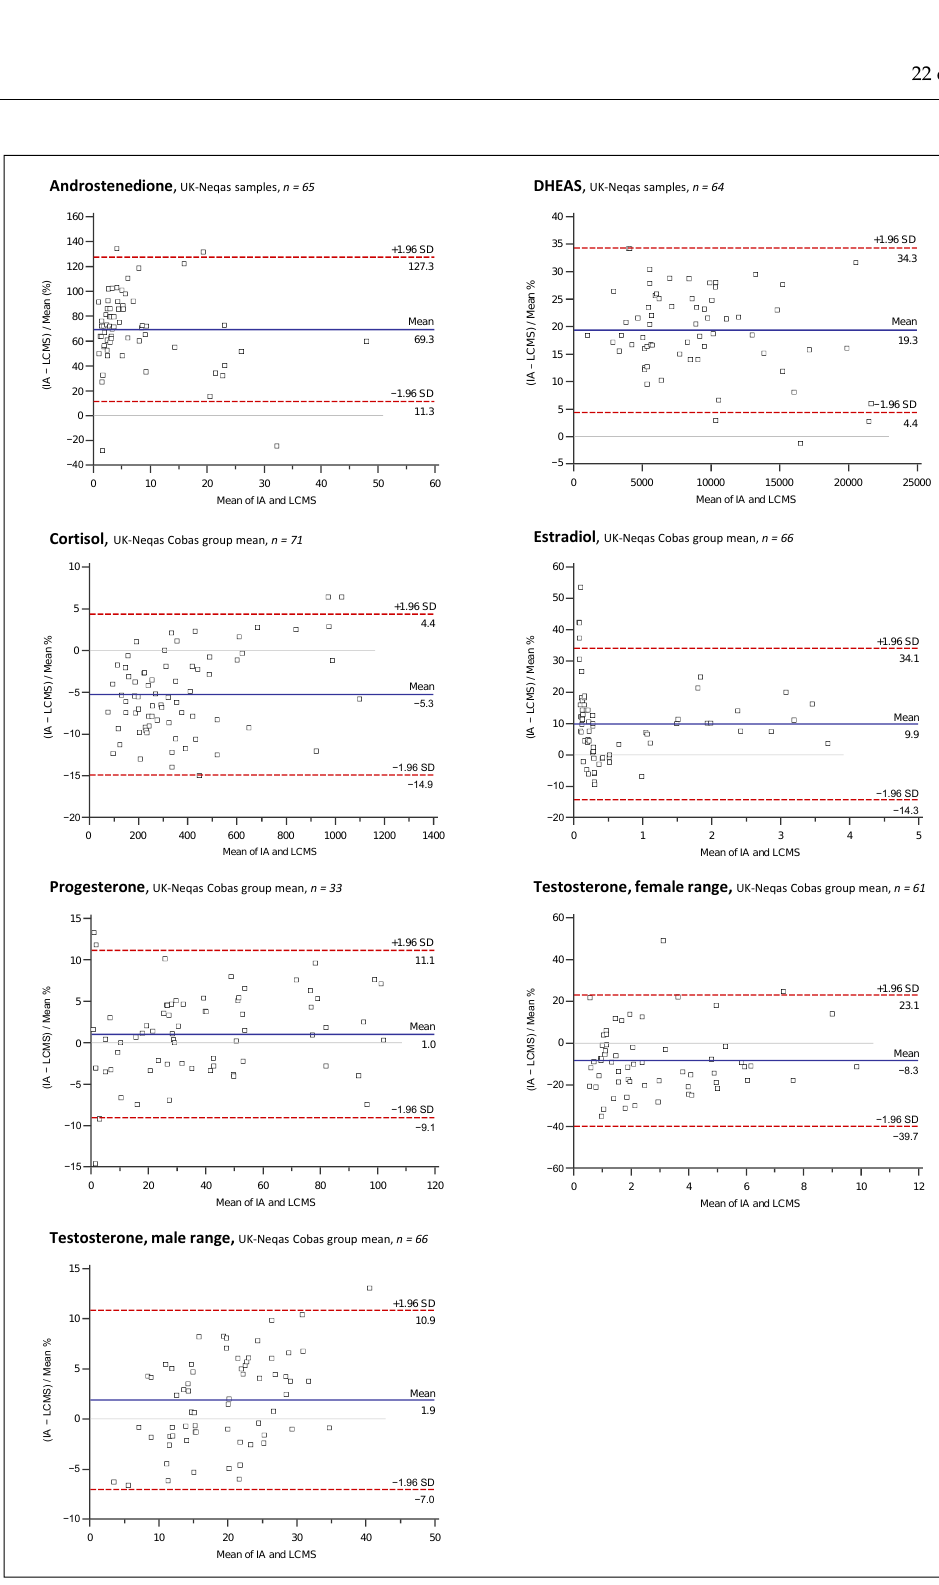
Figure 8. Bland and Altman plots comparing results from measuring proficiency testing samples of the UK NEQAS scheme. Measurement results of the LC-MS/MS (LCMS) method are plotted against results from in-house immunoassays (IAs) (androstendione, Siemens Immulite; dehydroepiandros- terone sulfate (DHEAS), Roche Cobas) or against the mean of all schemes participants using the Roche Cobas assay (all other plots). x -axis: mean of IA and LC-MS results in nmol/L; y -axis: difference be- tween both measurements in % of the mean of both methods.